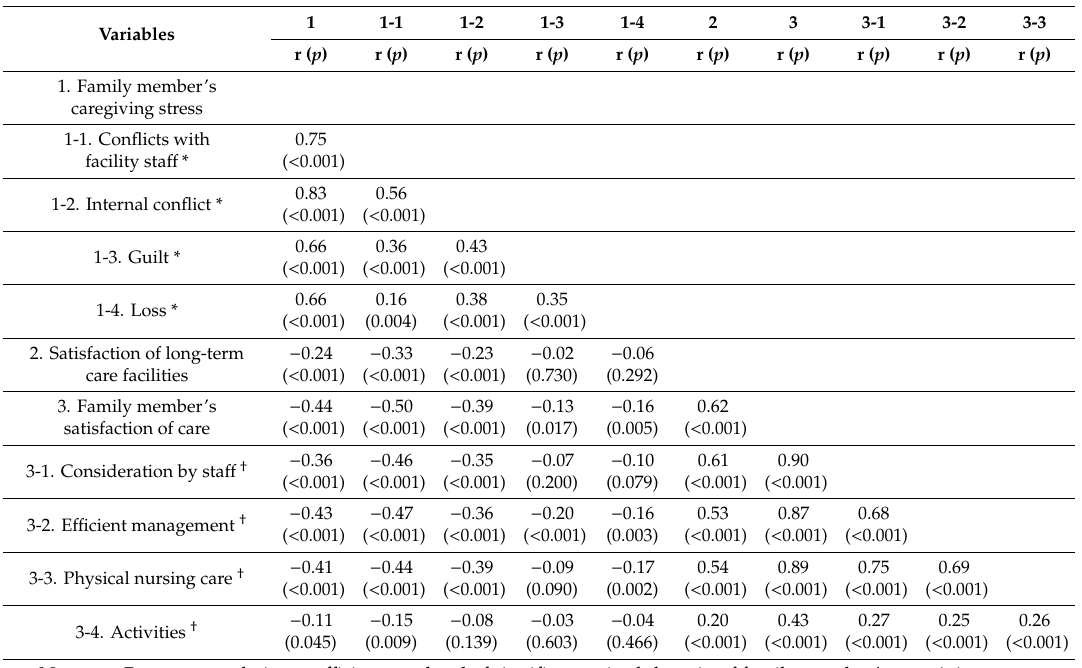
Table 6. Correlations between measured variables, N =